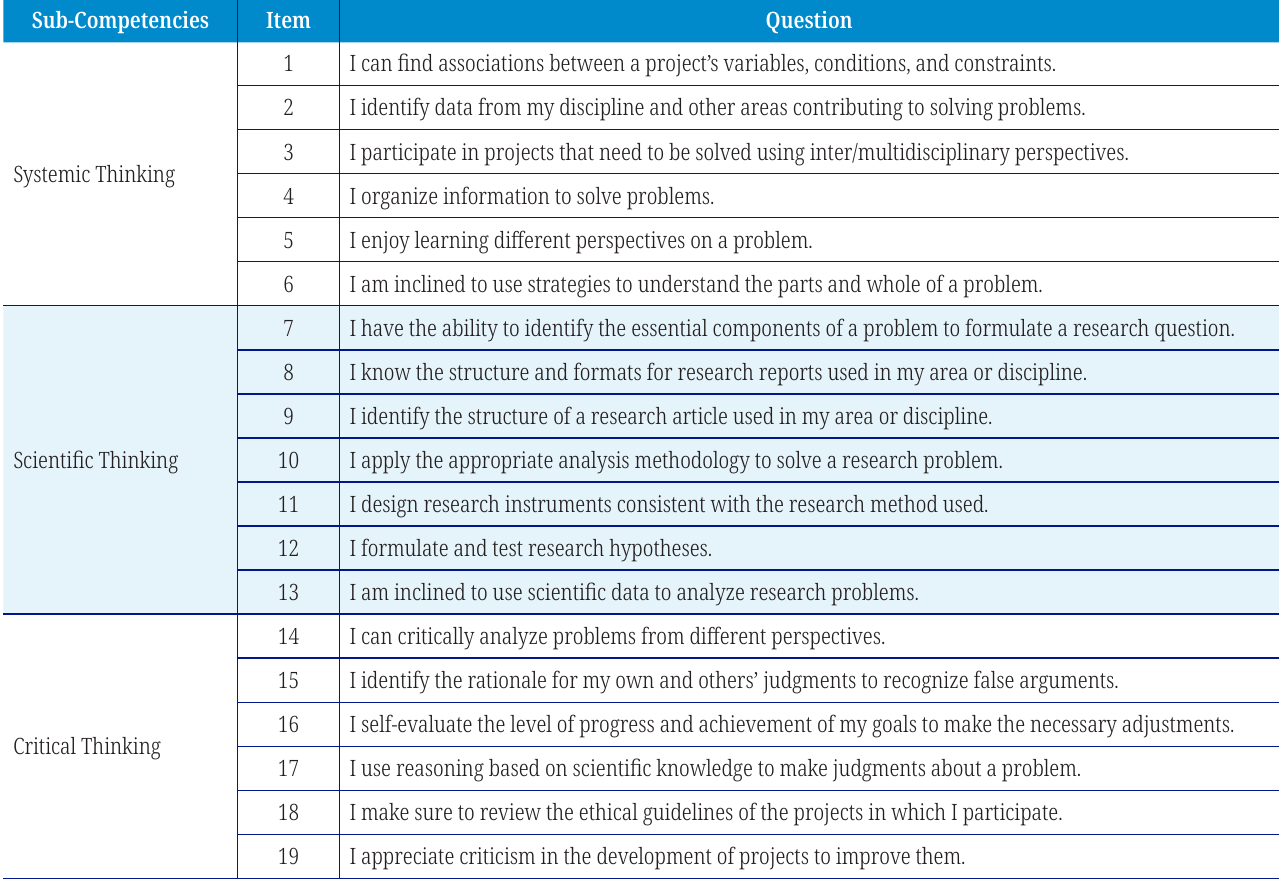
Table 2. eComplexity instrument